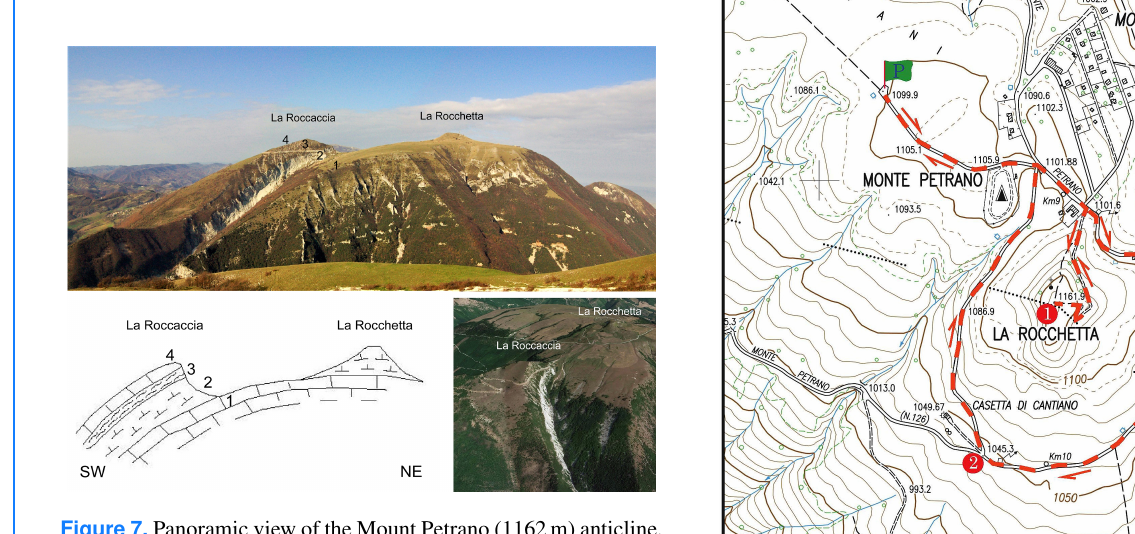
Figure 7. Panoramic view of the Mount Petrano (1162m) anticline, and an illustrative sketch of the geomorphological features caused by selective erosion. Note: 1 – Maiolica formation; 2 – Marne a Fucoidi formation; 3 – Scaglia Bianca formation; 4 – Scaglia Rossa formation. The image on the bottom right shows an aerial view of La Roccaccia (1065m) flatiron. (Map data © 2018 Google).